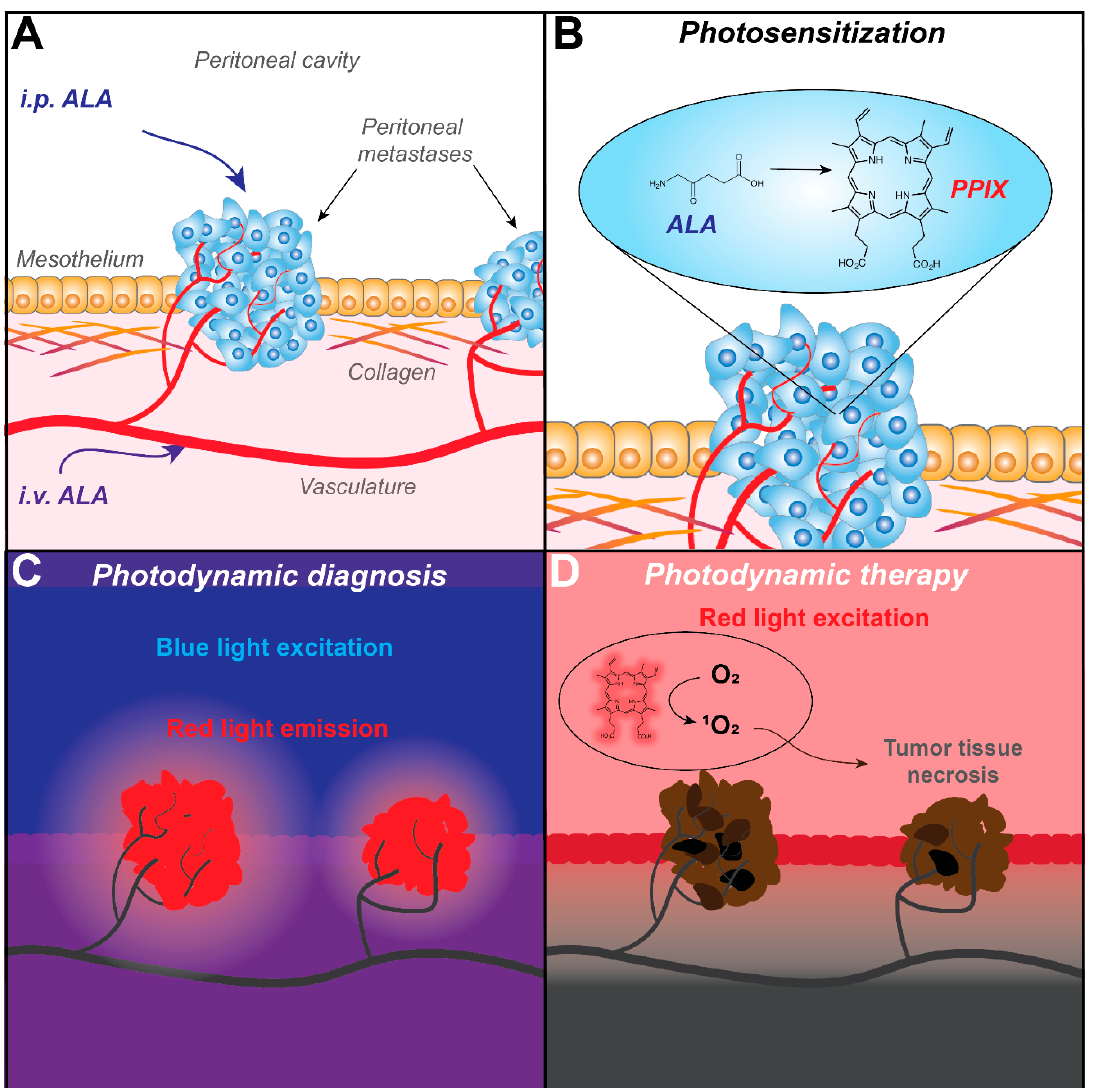
Figure 1. Fluorescence identification of peritoneal carcinomatosis (PCAR) by photodynamic diagnosis (PDD) and its subsequent treatment with photodynamic therapy (PDT), exemplified with ALA as a photosensitizer. ( A ) The photosensitizing agent ALA can be administered via either intraperitoneal (i.p.) or oral administration (i.v.) and accumulates in cancer tissues. ( B ) In cancer cells, ALA is preferentially metabolized to form PpIX, a fluorescent photosensitizer. ( C ) Under blue light, PpIX is excited and emits red fluorescence. Its detection can guide the surgical resection of the fluorescent tissues. ( D ) By exciting PpIX, for example with red light, reactive oxygen species such as 1 O 2 are formed through photochemical reactions and energy transfer. These cause oxidative damage to vital cellular components such as lipids, proteins and nucleic acids, culminating in massive tumor cell death.